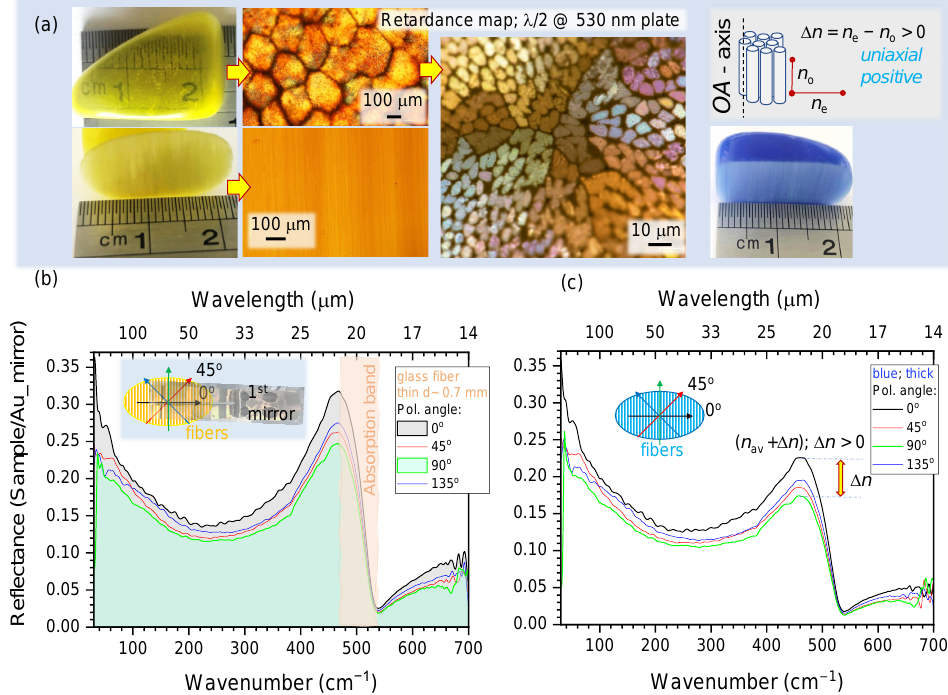
Figure 6. ( a ) “Cat-eye” silica fiber stone samples. Microscopy images were taken using cross Nicol polarisers with a λ /2 plate oriented at π /4 to the crossed polarisers; plate was for 530 nm wavelength to color render the retardance. Reflectance spectra measured with N 2 ITRO from silica-fiber “cat- eye” stones: yellow ( b ) and blue ( c ), which have form birefringence corresponding to the positive birefringence ∆ n ≡ n e − n o > 0 classified as the uniaxial postive crystal. Input polarisation was set linear at four angles 0, π /4, π /2, and 3 π /4. Inset in ( b ) shows orientation of polarisation in